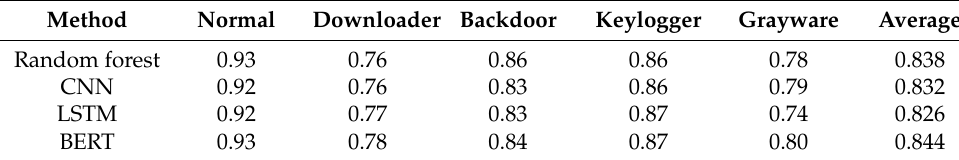
Table 3. Classification effect of the obfuscated dataset.